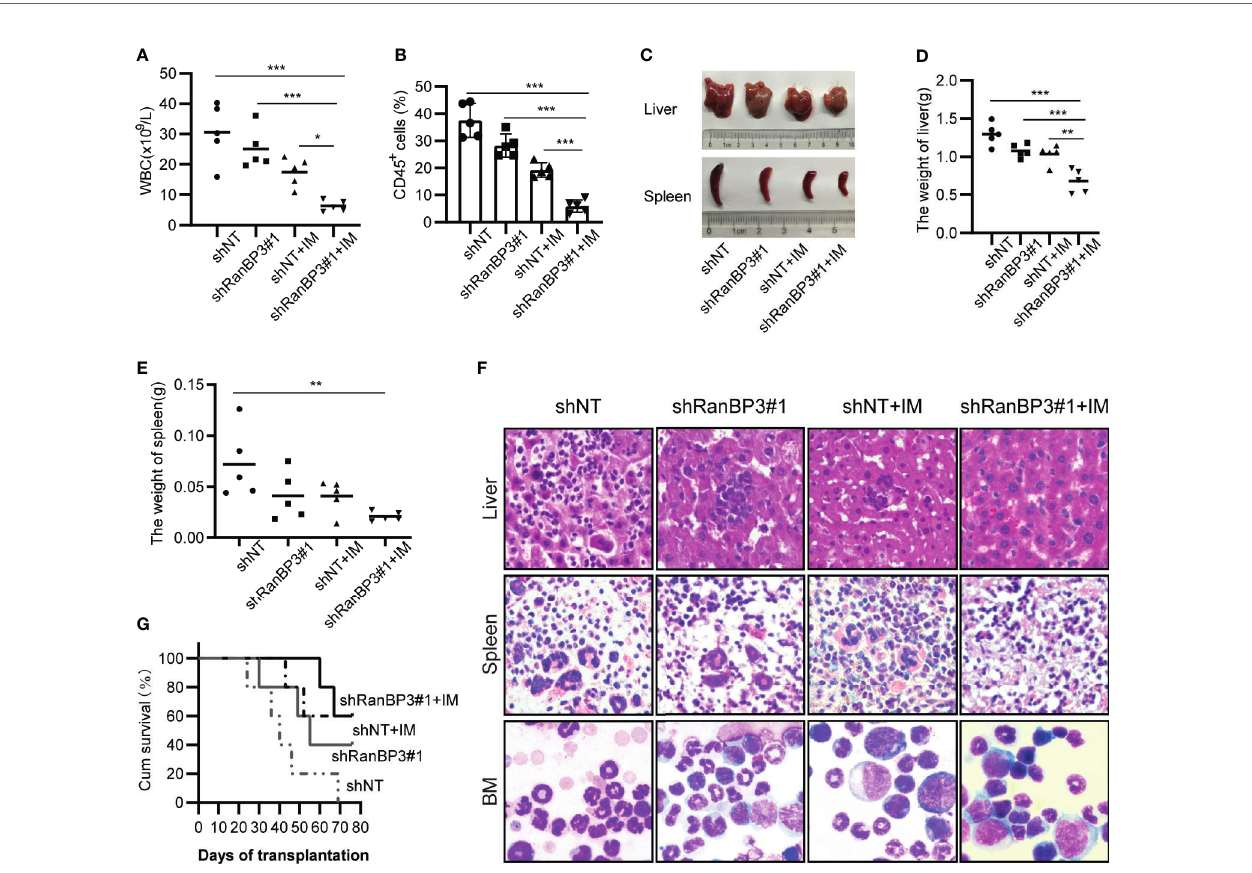
FIGURE 5 | RanBP3 silencing increases IM sensitivity in vivo . K562-shRanBP3 or K562-shNT cells were injected into the tail veins of NOD/SCID mice. 10 days after injection, 10mg/kg IM or control PBS was injected intraperitoneally for 14 days. (A) The total WBC counts in mice were determined. (B) The percentage of human CD45 + cells in BM cells of NOD/SCID mice was measured by FCM. (C) The images of livers and spleens were shown. The weights of livers (D) and spleens (E) were quanti fi ed. (F) Murine liver and spleen in fi ltration in 4 groups were analyzed by H&E, and bone marrow cells were checked with Wright ’ s stain. (G) Survival curves were drawn by GraphPad 8.0 and analyzed by Kaplan – Meier methods. *p< 0.05, **p< 0.01 and ***<